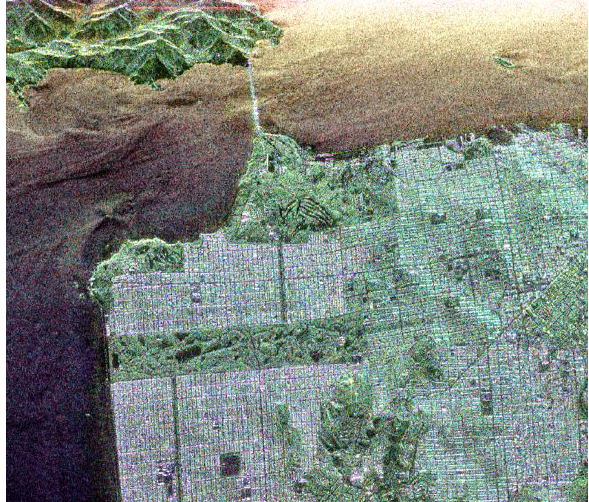
Figure 1. AIRSAR color-coded Pauli image of San